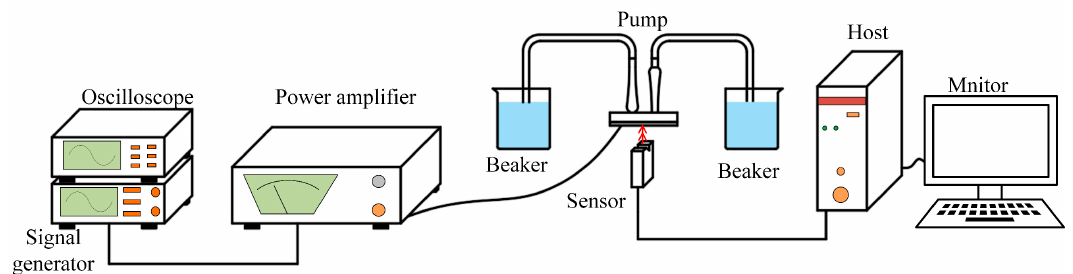
Figure 7. Schematic diagram of piezoelectric oscillator amplitude detection.